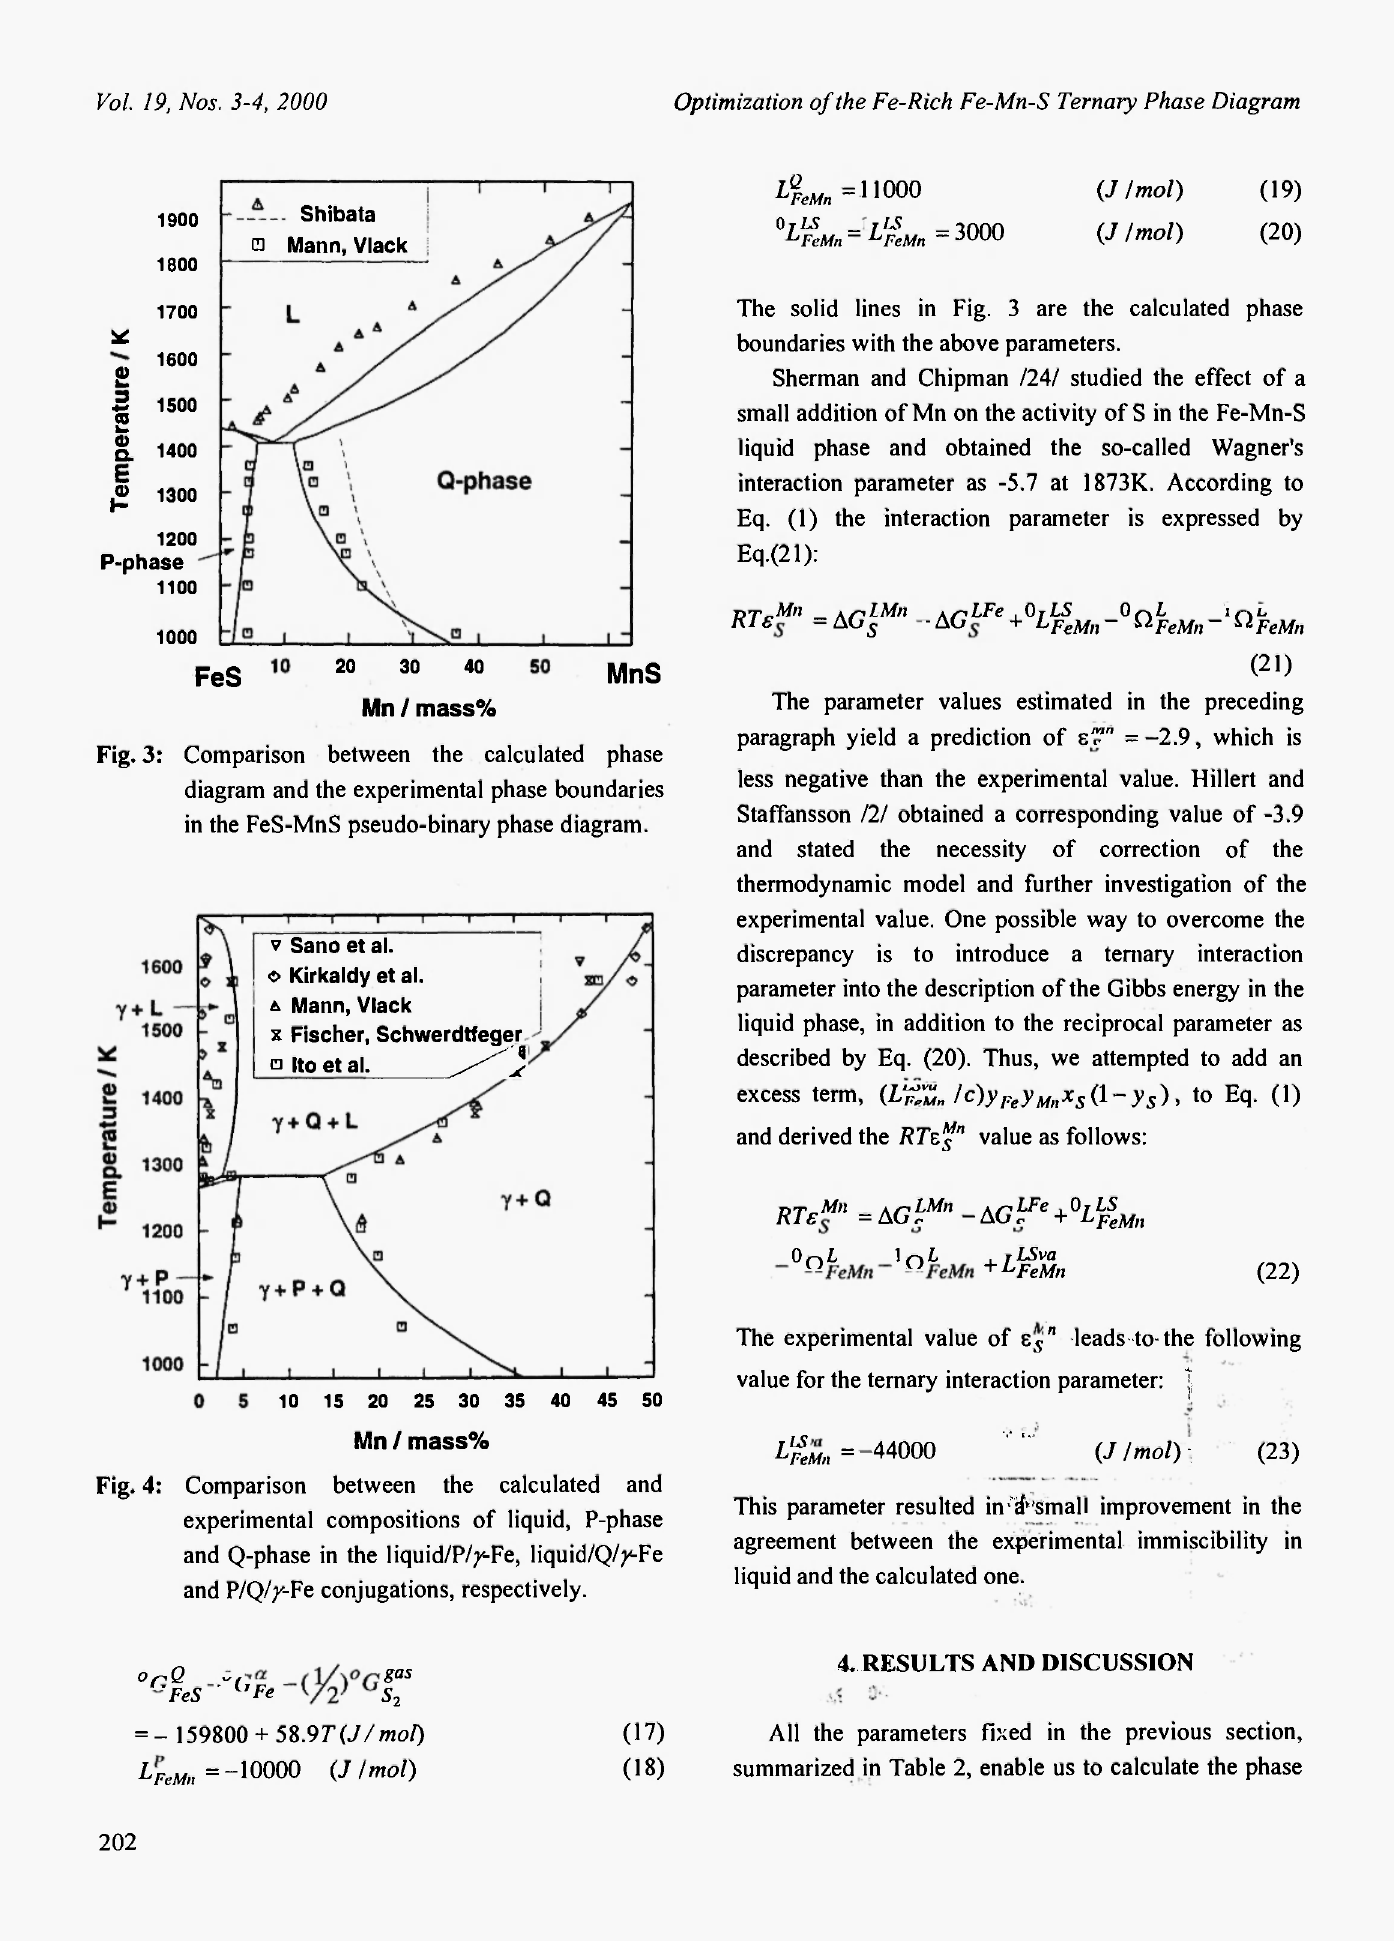
Fig. 4: Comparison between the calculated and experimental compositions of liquid, P-phase and Q-phase in the liquid/P//-Fe, liquid/Q/y-Fe and P/Q/^-Fe conjugations,